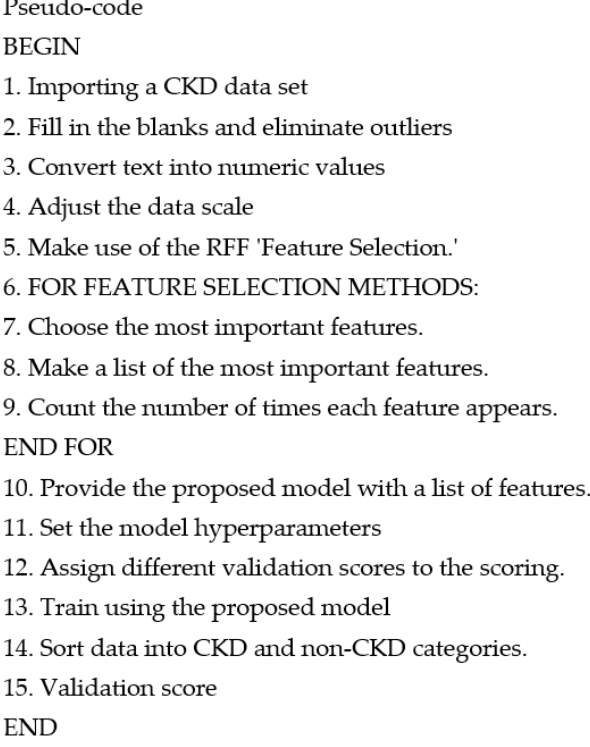
Figure 6. Pseudo-Code of the proposed model.